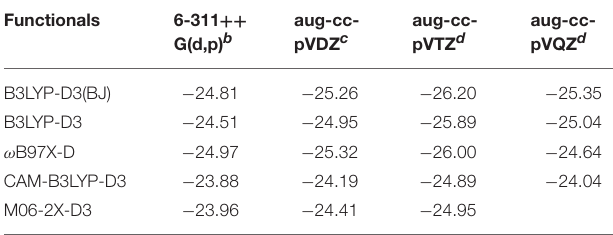
TABLE 3 | Binding energies of conformer 5 with different functionals and basis sets (in kcal/mol) a . Functionals